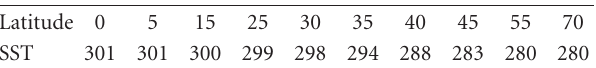
Table 2: Sea surface temperature (SST) of the basic state. The SST is linearly interpolated between two latitudes shown. It is taken to be symmetric with respect to the